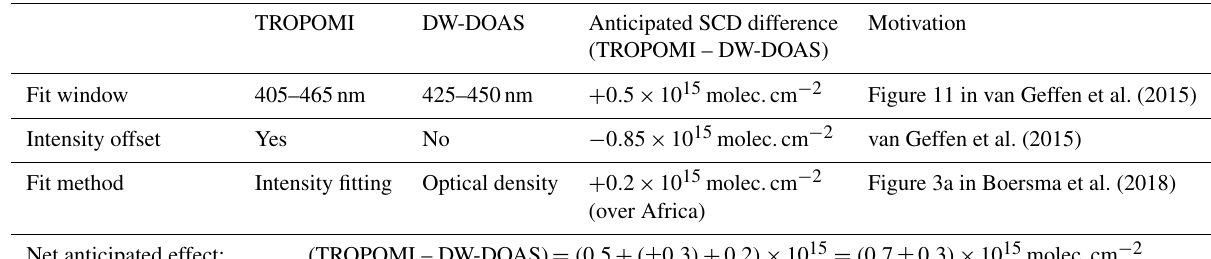
Figure 5. (left) Global DW-DOAS NO 2 SCDs scaled with geometric AMFs (for clearer data visualisation) for all single orbits of 1d in Jan- uary, April, July, and October of 2005, and (right) the relative differences with QA4ECV calculated as (QA4ECV – DW-DOAS) / QA4ECV and expressed in percentage. The latitudes are limited to [60 ◦ S, 80 ◦ N]. Data from all-sky conditions have been used. Table 3. Anticipated SCD differences between TROPOMI and DW-DOAS owing to retrieval implementation differences, based on the